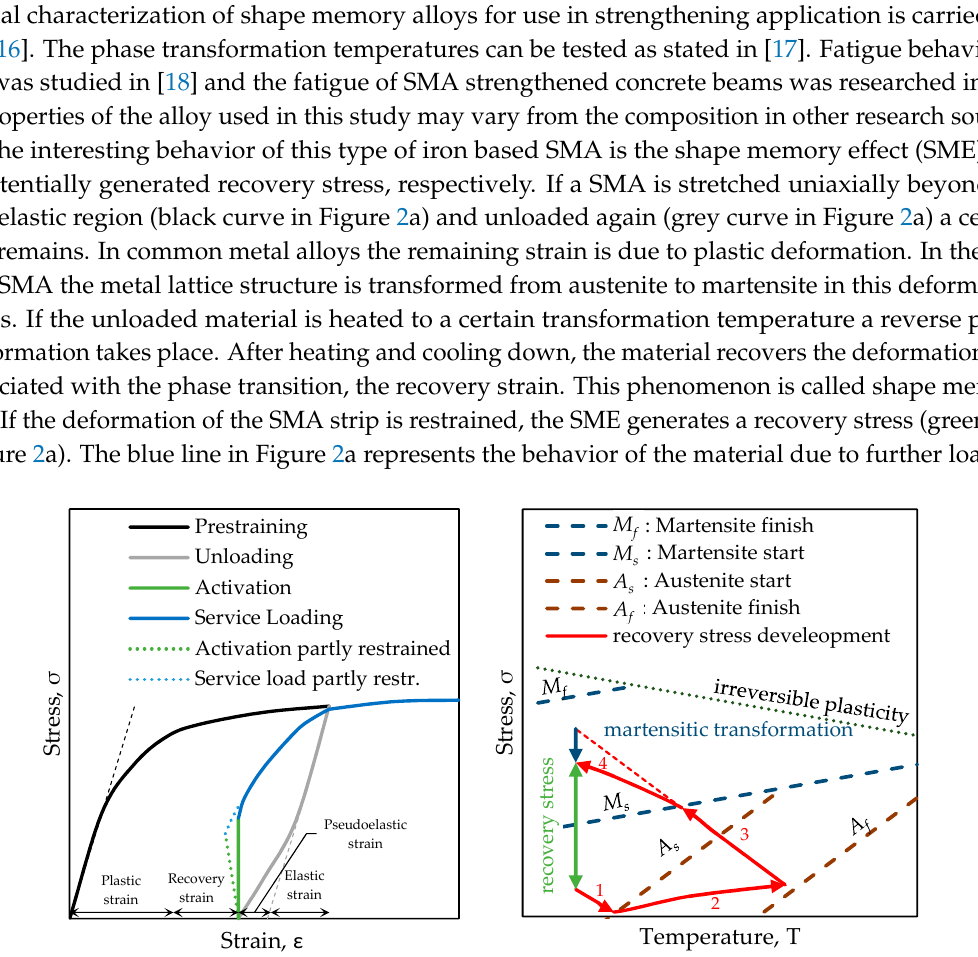
application for prestressing, adapted from [15]; ( b ) schematic illustration of the activation and recovery